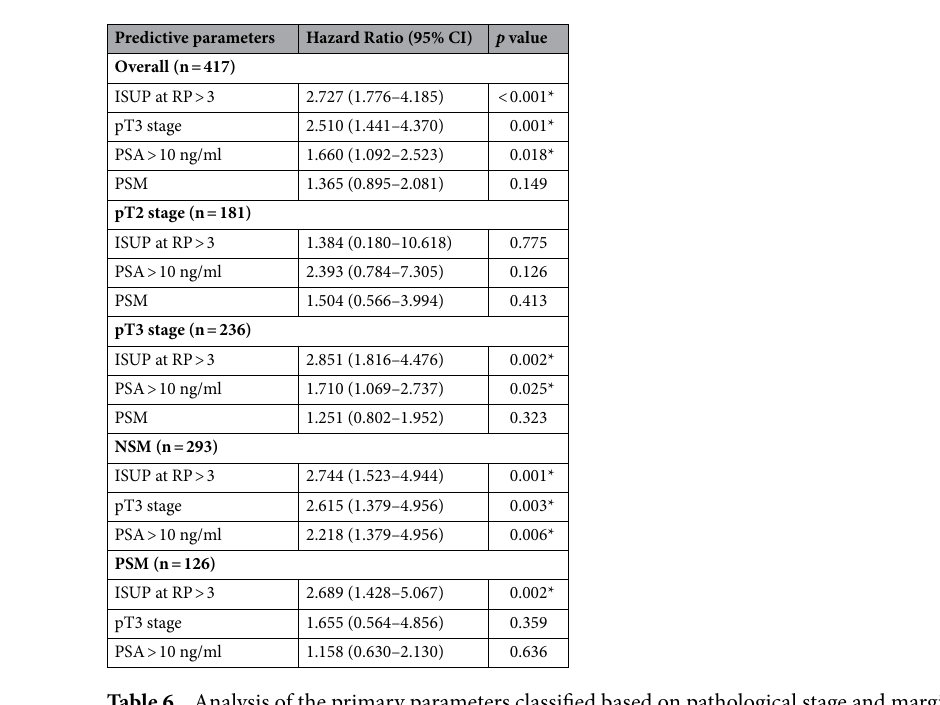
Table 6. Analysis of the primary parameters classified based on pathological stage and margin status to predict the 5-year biochemical recurrence-free survival through multivariable Cox regression analysis. pT pathological T, PSA prostate-specific antigen, ISUP International Society of Urological Pathology, RP radical prostatectomy, NSM negative surgical margin, PSM positive surgical margin, * p value for difference between biochemical recurrence in multivariable analysis <